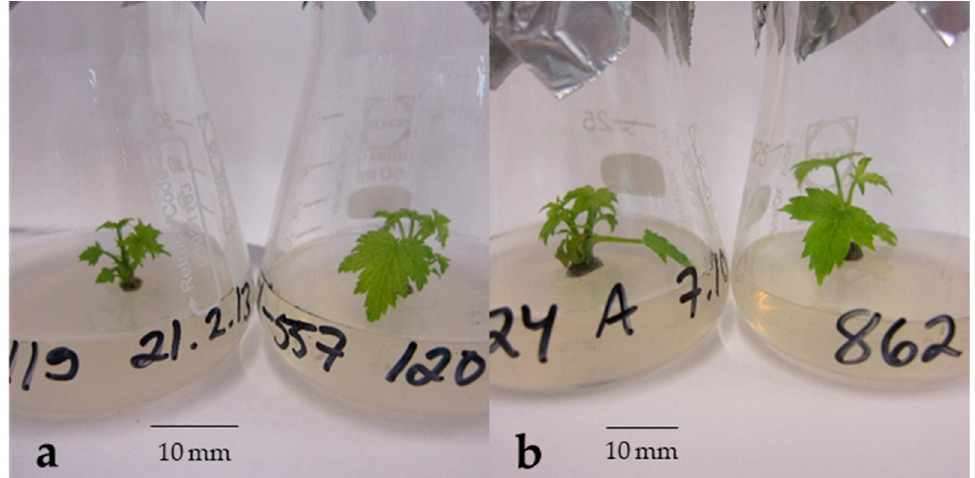
Figure 6. Microplantlets of cv. Vilma after seven weeks in vitro culture in the protocol experiment. ( a ) Shoots regenerated from non ‐ desiccated and non ‐ cryopreserved control buds. ( b ) Shoots regen ‐ erated from buds cryopreserved without desiccation and rehydrated 14 day after fast